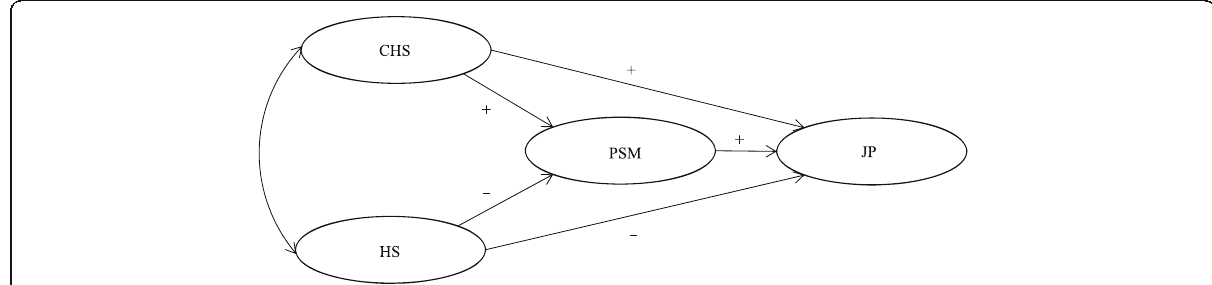
Fig. 1 Proposed model of how challenge stress (CHS), hindrance stress (HS), and public service motivation (PSM) influence job performance